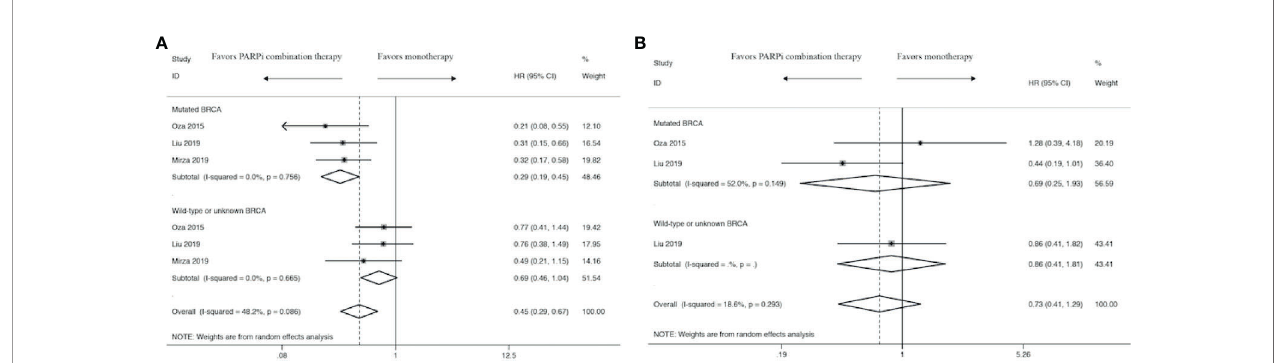
FIGURE 4 | Forest plot of the meta-analysis of subgroup analysis estimating pooled hazard ratios and 95% CI of progression-free survival (A) and overall survival (B) for patients assigned to intervention treatment, compared with those assigned to control treatment concerning